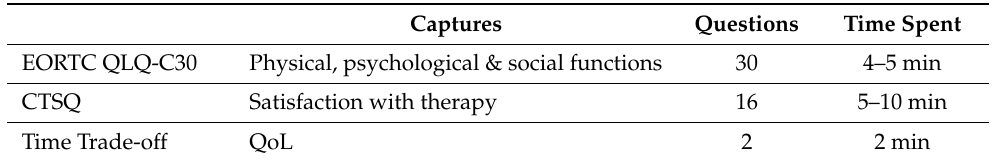
Table 4. Proposal for ePRO in daily clinical practice for advanced STS. CTSQ, Cancer Therapy Satisfaction Questionnaire, QoL, quality of life, STS, soft tissue